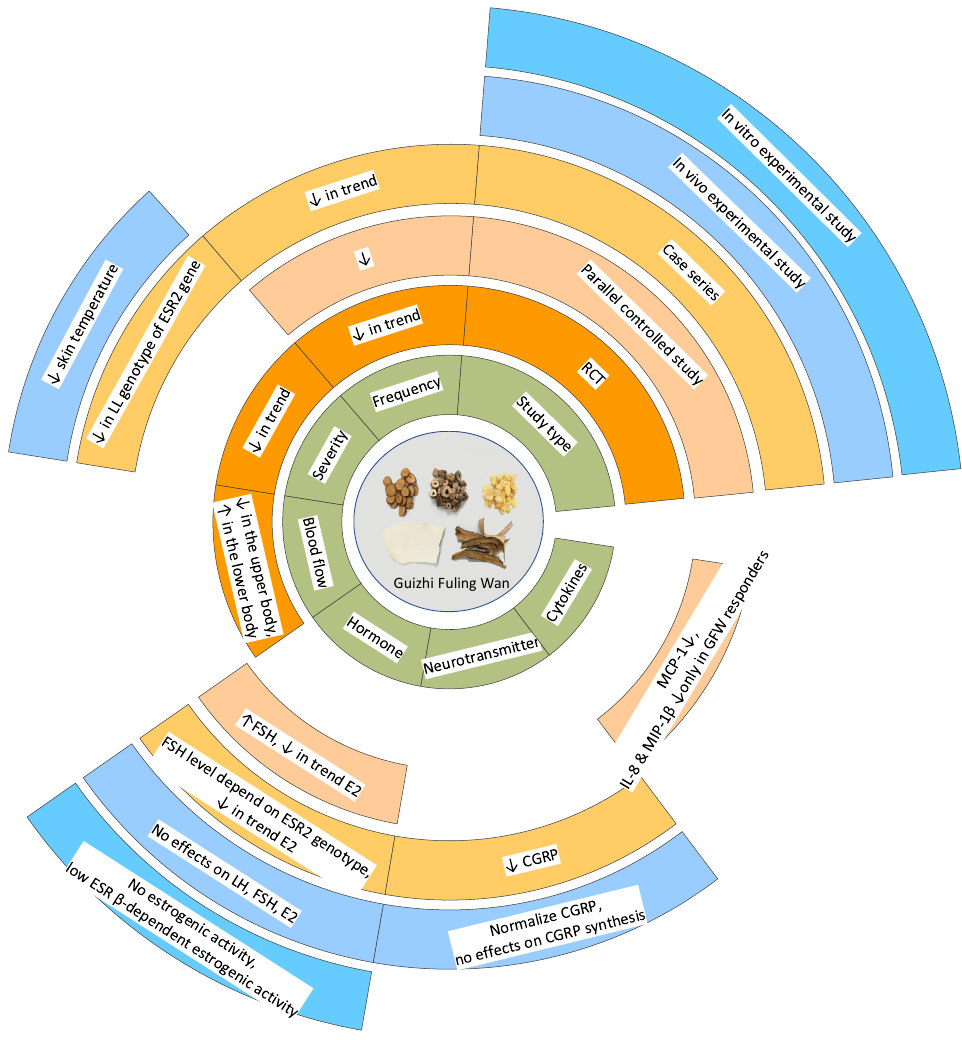
Figure 4. Therapeutic effects of Guizhi Fuling Wan on menopausal hot flushes across different types of studies. Notes: CGRP: calcitonin gene-related peptide; E 2 : estradiol; ESR: estrogen receptor; FSH: follicle-stimulating hormone; 1IL: interleukin; LH: luteinizing hormone; LL: two long alleles; MIP: macrophage inflammatory protein; MCP: serum monocyte chemotactic protein; RCT: randomized controlled trial.